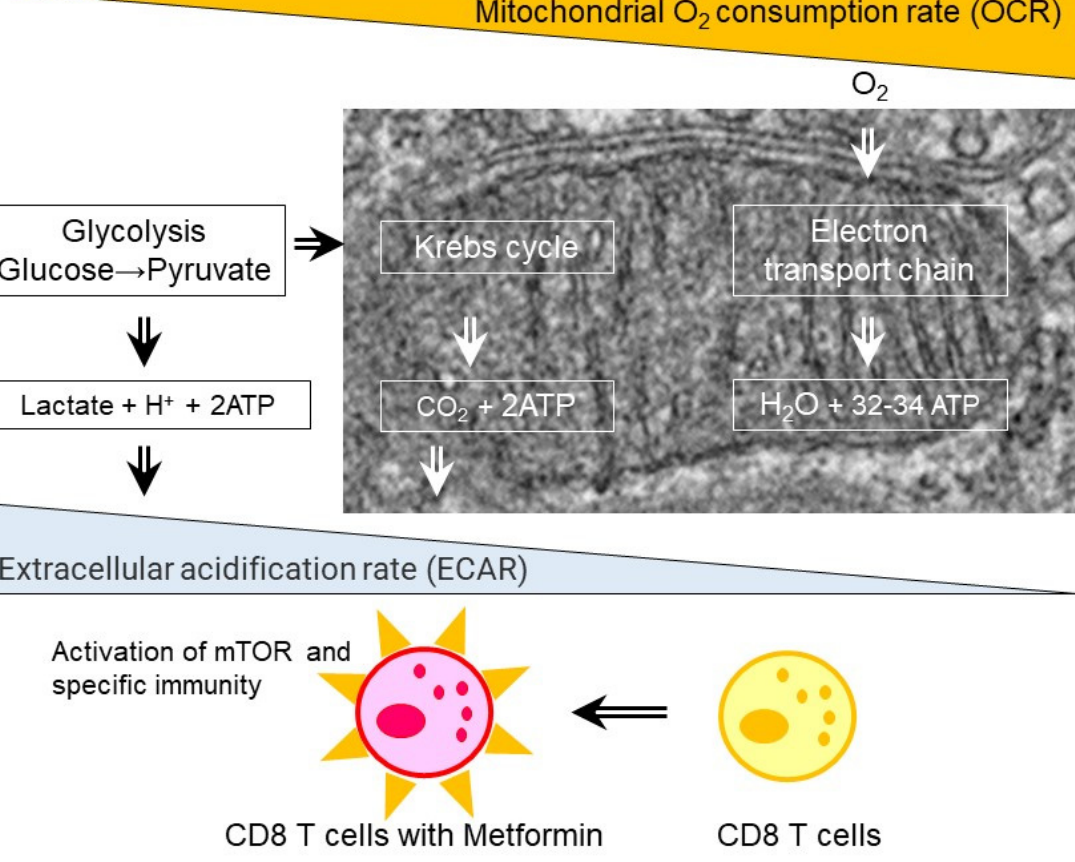
Figure 3. Effect of metformin on CD8 T cells. Metformin treatments in the patients with type 2 diabetes and obese mice fed with high fat diet results in increase in extracellular acidification rate (ECAR) and oxygen consumption rate (OCR) ratio, activation of mammalian target of rapamycin (mTOR), and enhanced specific immunity.